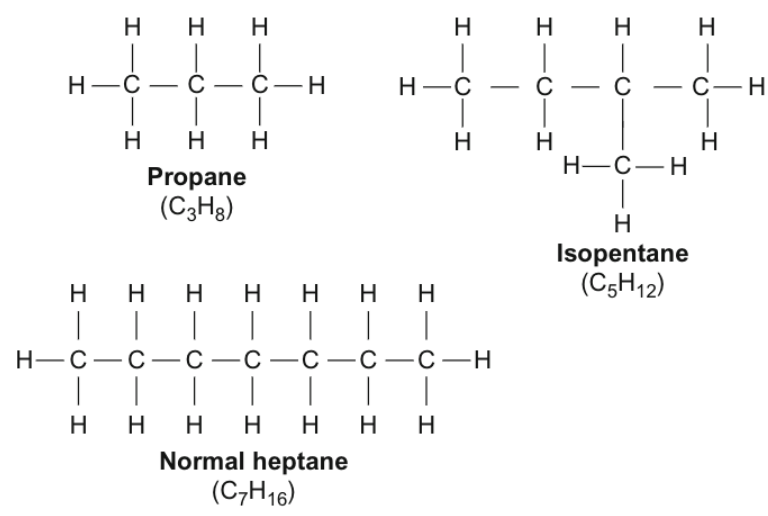
Figure 2. Examples of paraffins. This figure was redrawn based on [24].